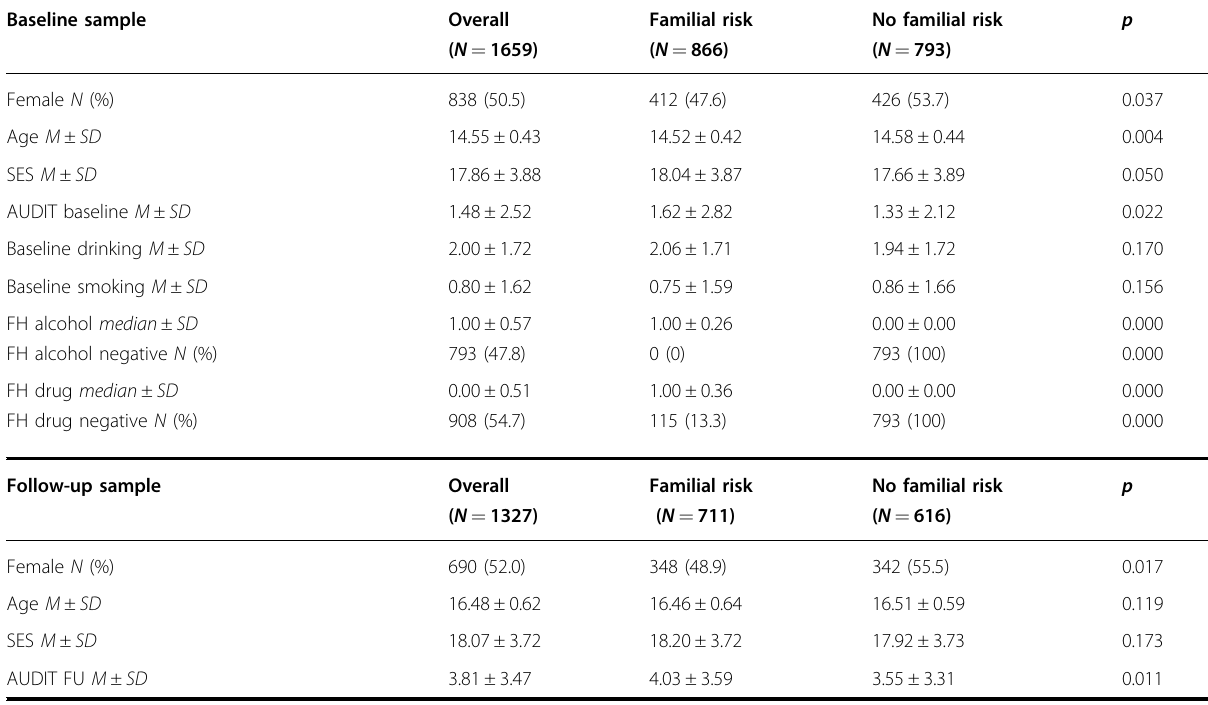
Table 1 Demographic and clinical